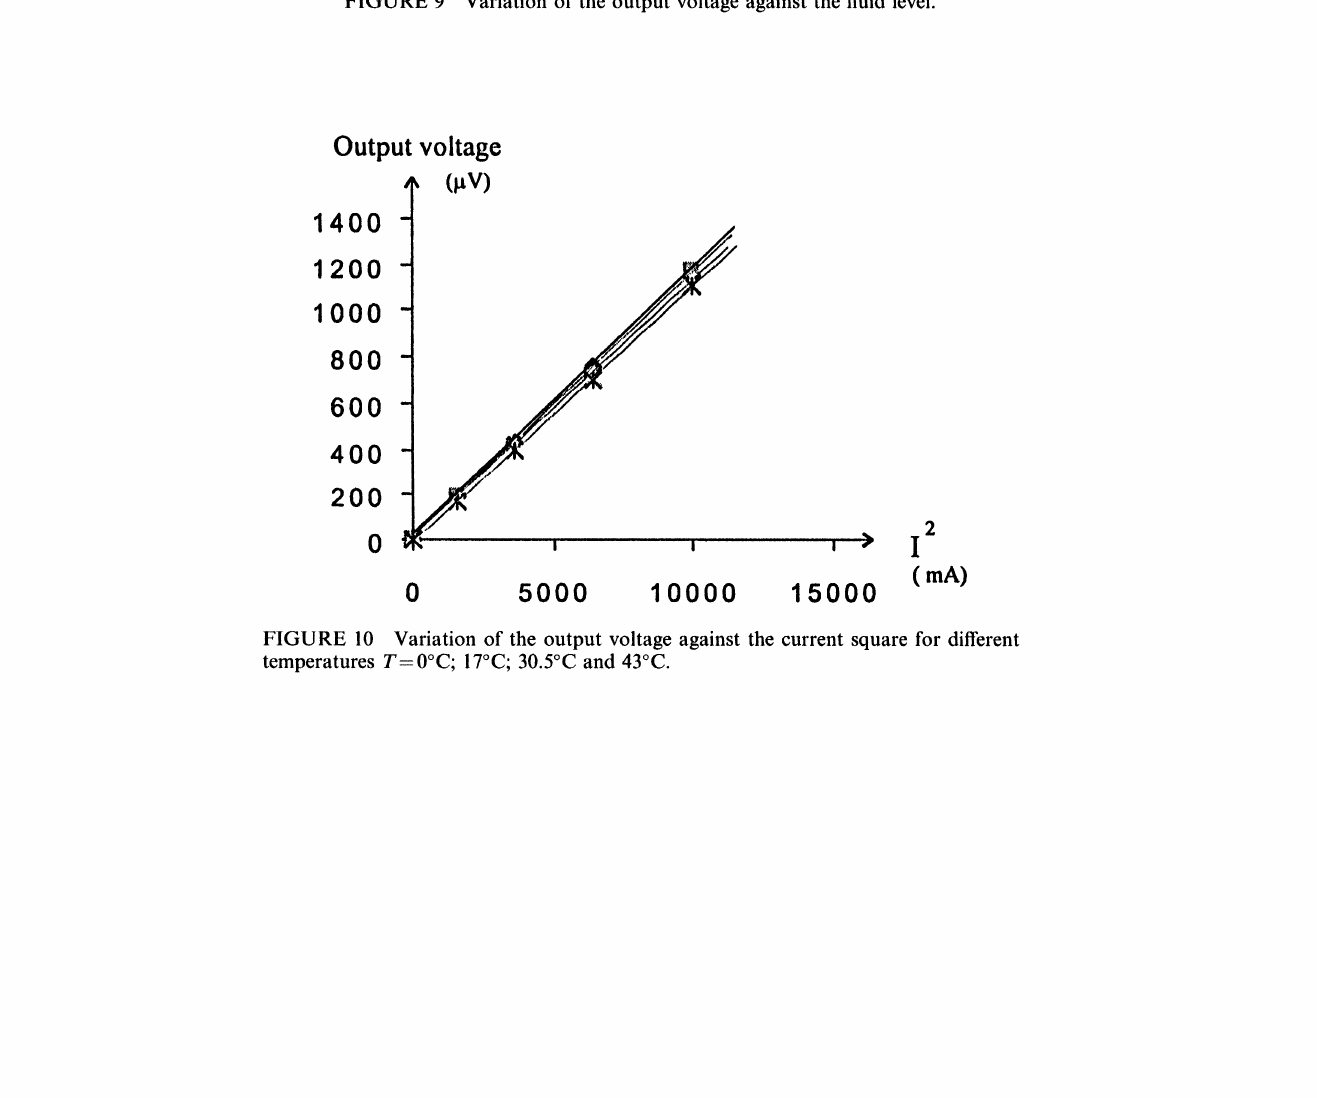
FIGURE 9 Variation of the output voltage against the fluid level.